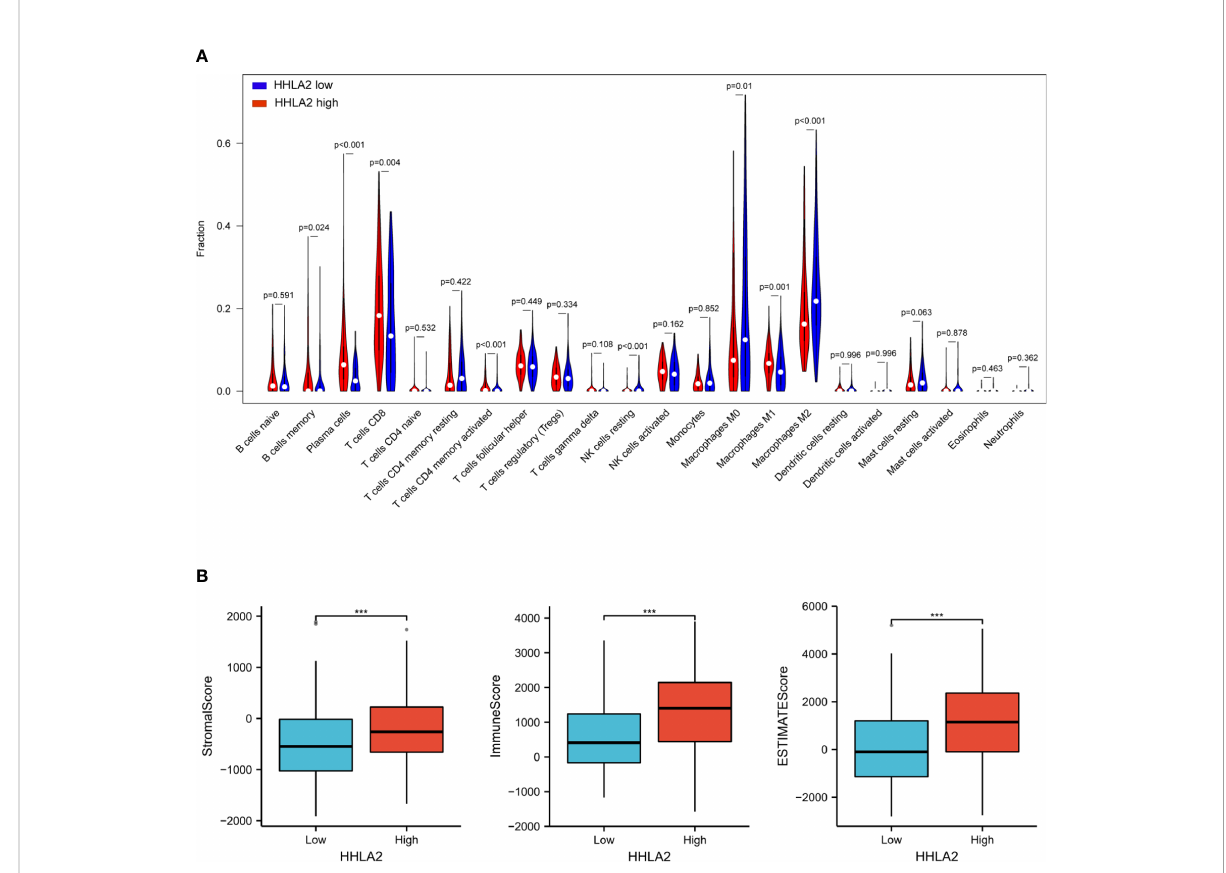
FIGURE 3 Associations among HHLA2, tumor immune in fi ltration and the tumor microenvironment in SKCM. (A) Varied abundances of 22 in fi ltrating immune cell types in high and low HHLA2 expression groups. (B) Association between high/low HHLA2 expression group and TME score. ***P<0.001. P values <0.05 are in